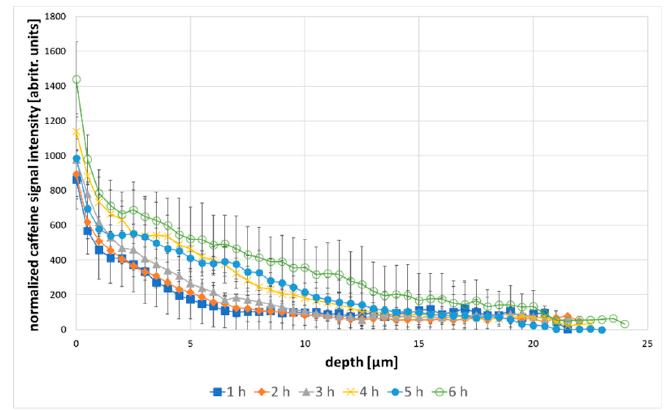
Figure 3 . Caffeine depth profiles over 6 h incubation time with 2% caffeine, the error bars are showing the standard deviation.